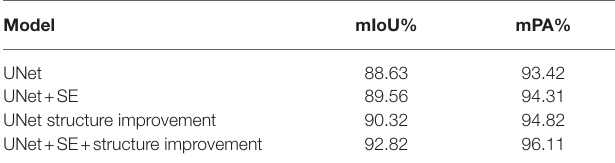
TABLE 2 | Performance comparison of the different models.